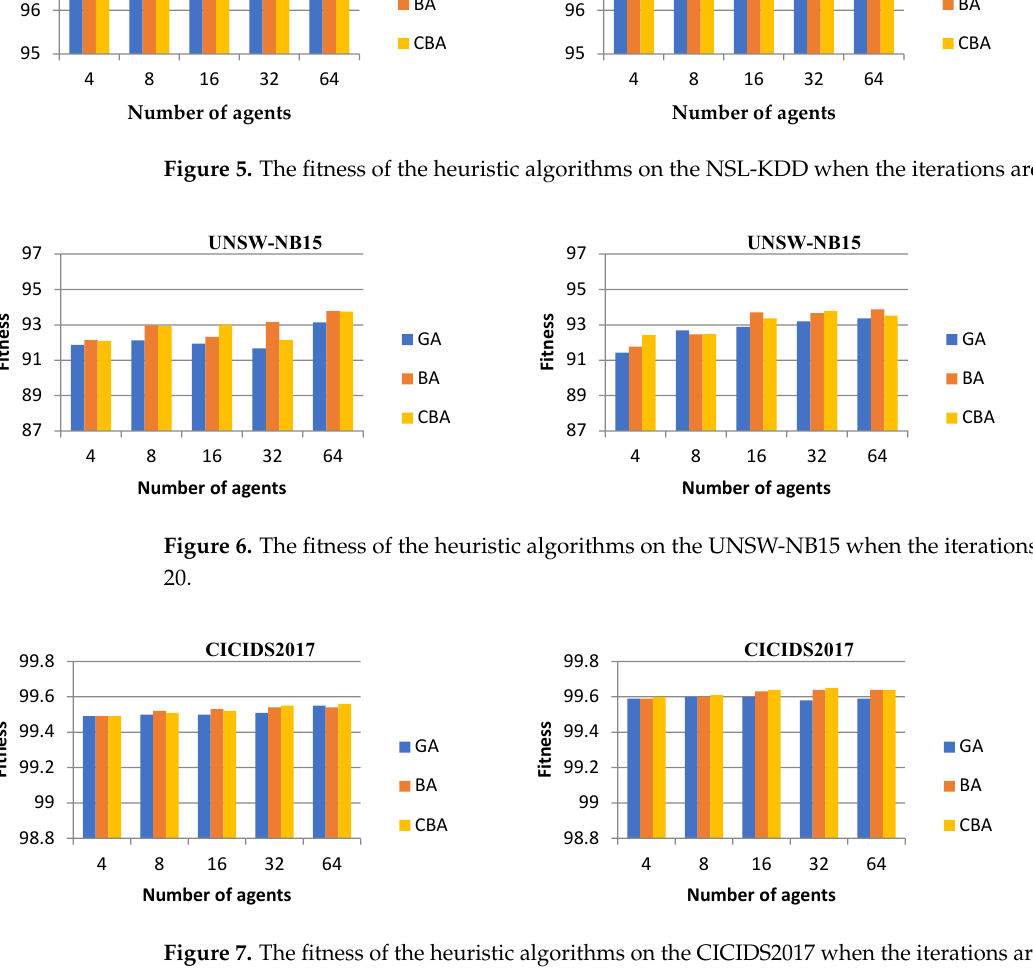
Figure 7. The fitness of the heuristic algorithms on the CICIDS2017 when the iterations are 10 and 20.